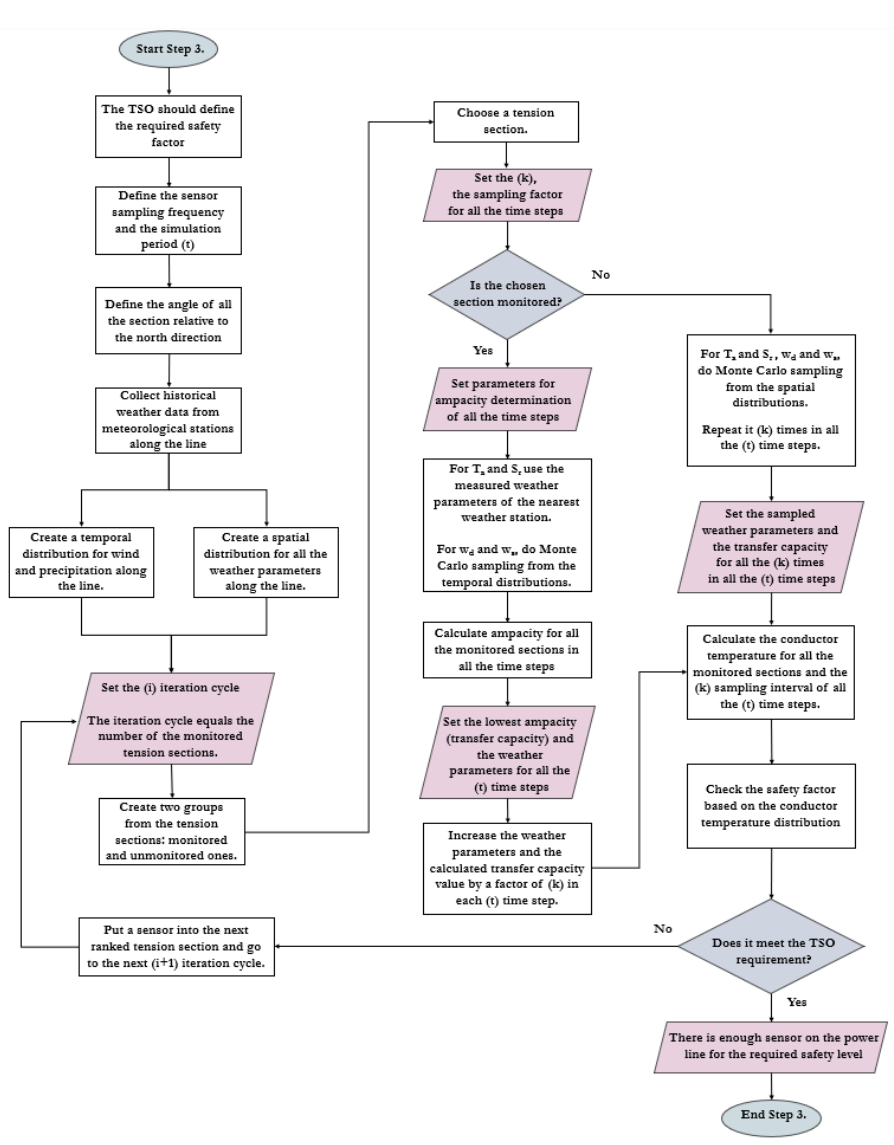
Figure 4. Flowchart of Step 3 in the novel sensor placement protocol based on [16].